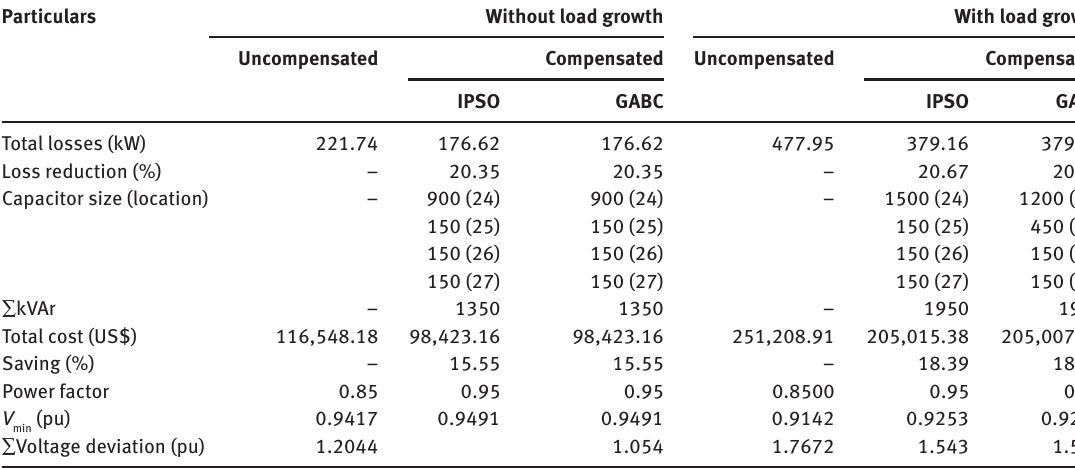
Table 7: Simulation Results of the 34-Bus Distribution Network after SC Placement Using the IVS Approach.